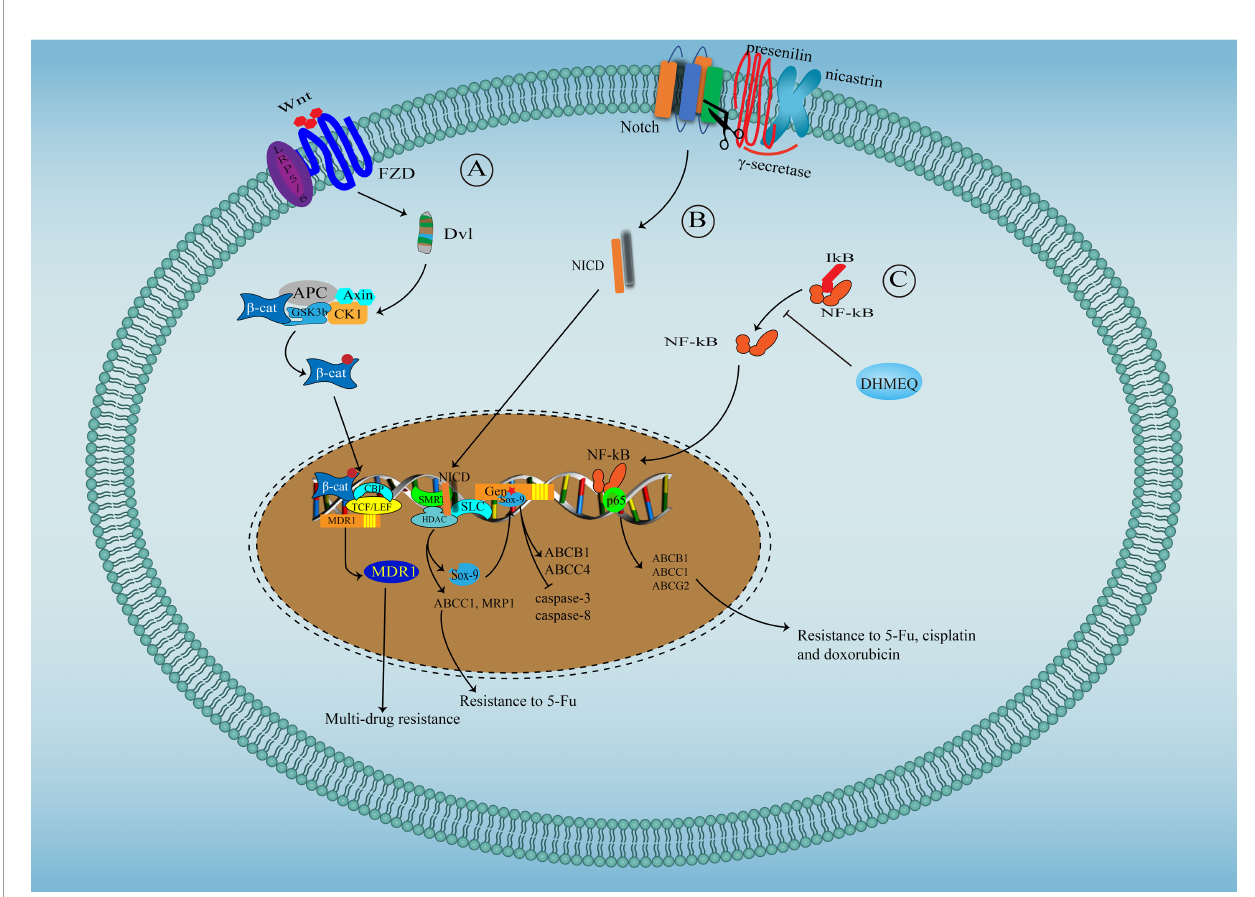
FIGURE 2 | Signaling pathways involved in drug resistance in cholangiocarcinoma. (A) Wnt/ b -catenin signal pathway in drug resistance in cholangiocarcinoma: Wnt binds to its receptor-Frizzled to activate Dsh protein, which phosphorylate and inactivate GSK3 b , facilitating the translocation of free and unphosphorylated b -catenin from the cytoplasm to the nucleus, where b -catenin binds to TCF/LEF to promote MDR1 expression. (B) Notch signal pathway in drug resistance in cholangiocarcinoma: After Notch activation, g -secretase (Presenilin and Nicastrin) cleaves Notch COOH-terminal fragment. NICD, released into the cytoplasm, further translocate to the nucleus, where NICD interact with SKIP and CSL, leading to SMRT/HDACs dissociation and converting CSL to a transcriptional activator to initiate the expression of ABCC1, MRP1 and Sox9, which can further promote the expression of ABCB1 and ABCC4. (C) NF-kB signaling pathway in drug resistance in cholangiocarcinoma: NF-kB translocate into the nuclear to initiate the expression of ABCB1, ABCC1 and